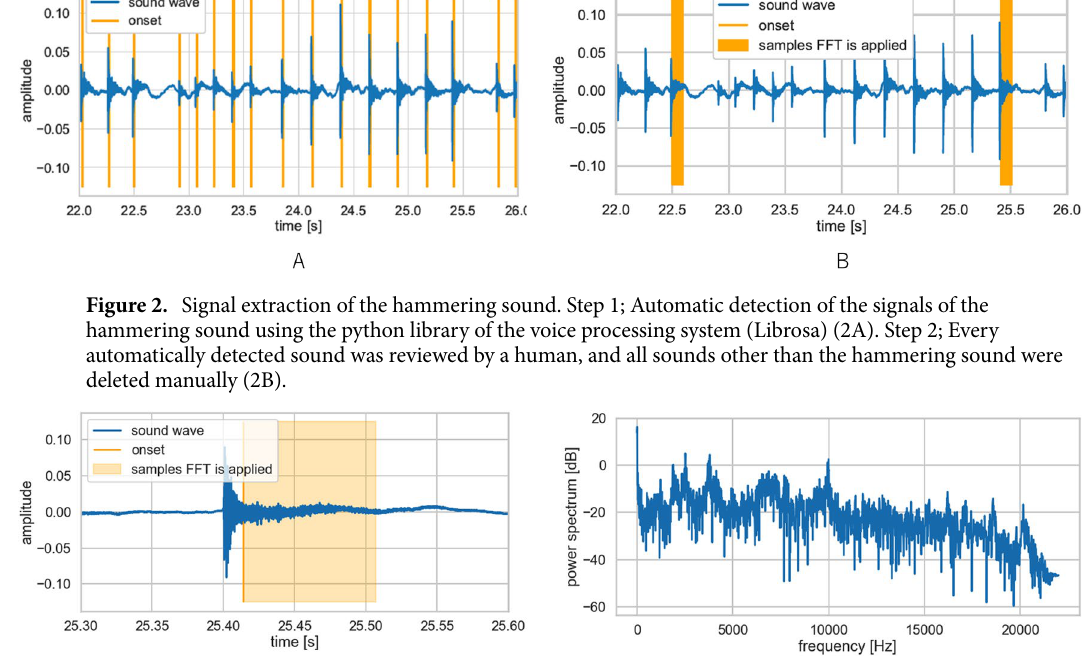
Figure 3. Signal extraction of the hammering sound. Step. 3; The hammering sound was assessed during the period from the onset to 0.093 s (3A). Input variable setting; the sound data was analysed by Fast Fourier transform analysis